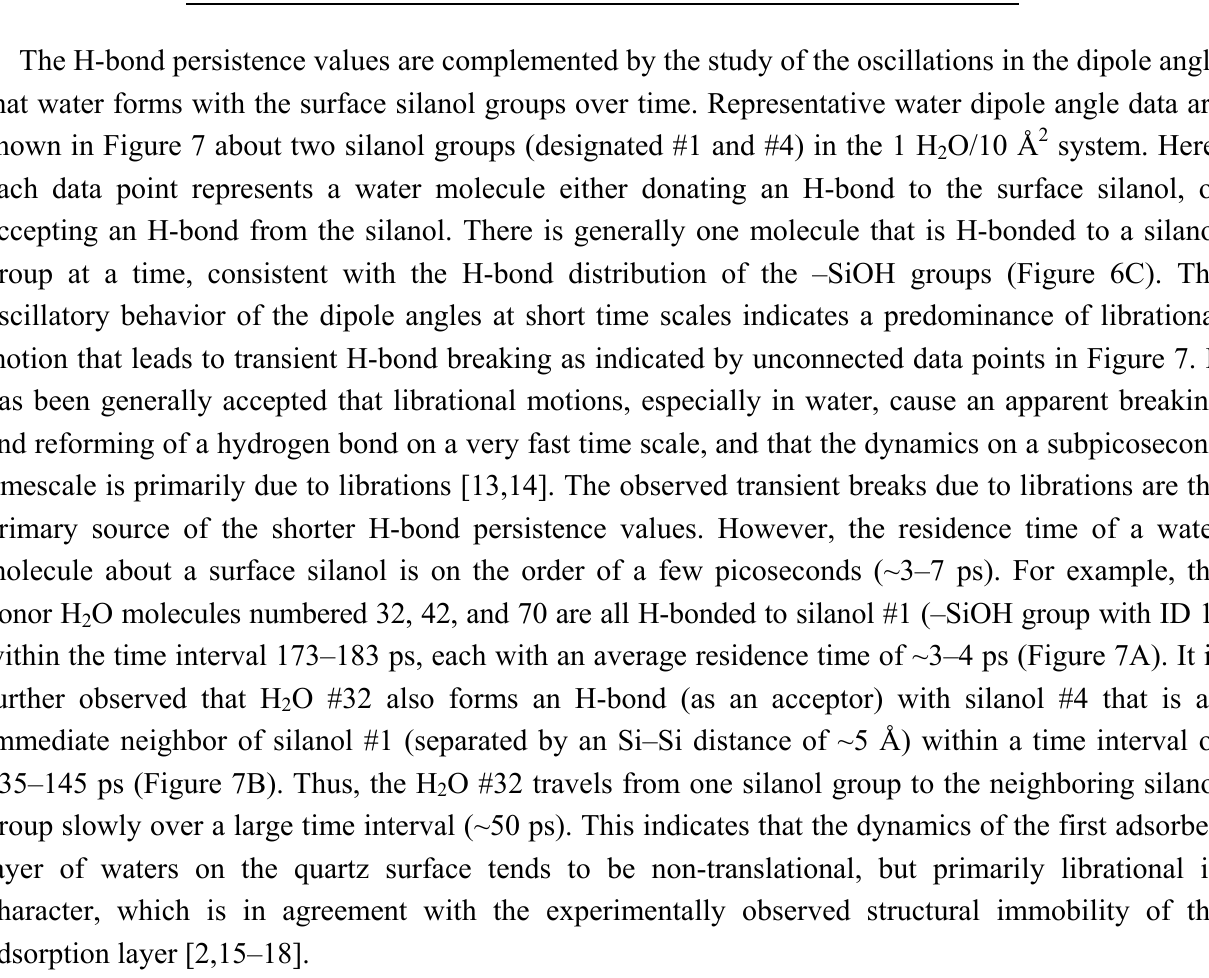
O…H O and H O…SiOH hydrogen bonds as a function 2 2 2